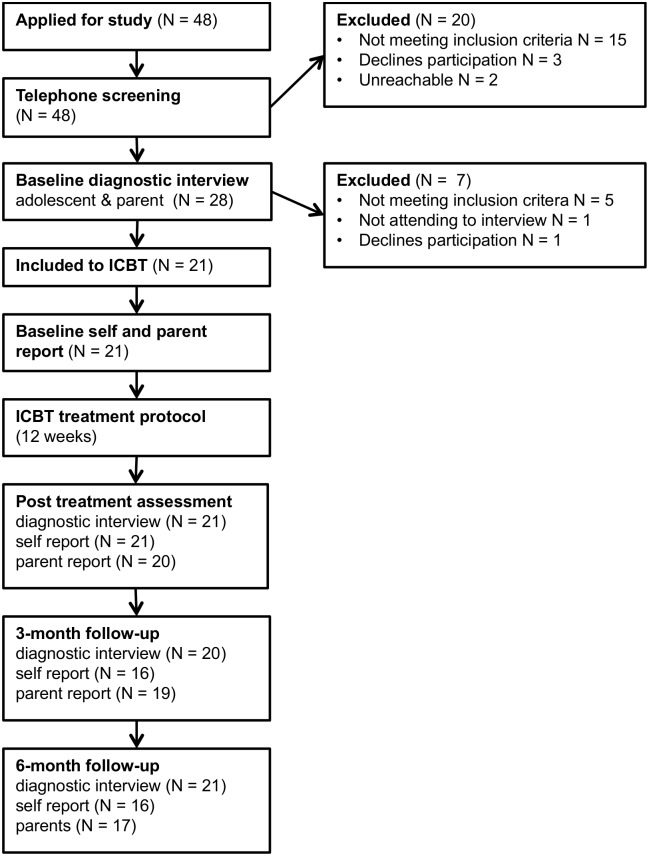
Study flow chart.